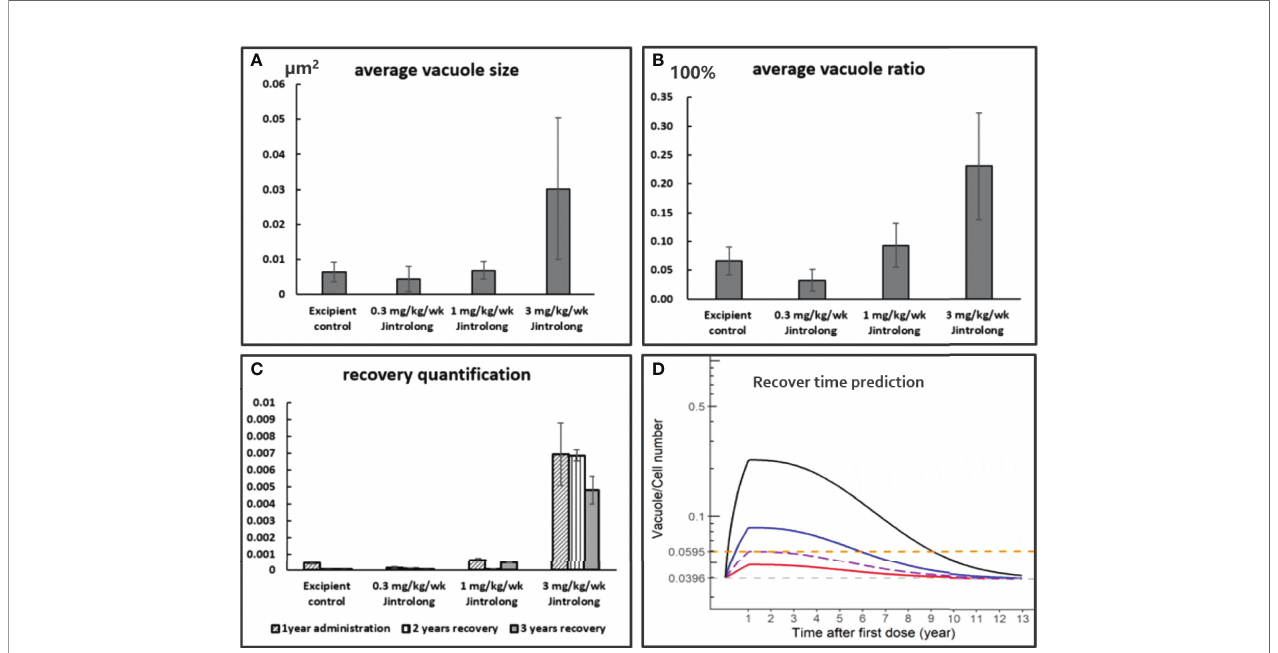
FIGURE 8 | Quanti fi cation and Model based prediction of vacuolation recovery in the CP of cynomolgus monkeys. (A) The average vacuole size is dose-dependent, the y axis is the average vacuole size by µm 2 . (B) The average vacuole ratio is dose-dependent, the y axis is the average vacuole ratio in total CP epithelium. (C) The vacuolation recovery quanti fi cation by average vacuole area multiple average vacuole ratio of cells in CP epithelium. The vacuolation in CP epithelium is completely reversible in middle dose 1 mg/kg/week Jintrolong group and partially reversible in high dose 3 mg/kg/week Jintrolong group. (D) The modeling and simulation data are based on a pharmacokinetic modeling software package NONMEM (the pharmacokinetic modeling method shown in Model Based Prediction of Vacuolation Formation and Recovery in the Cynomolgus Monkeys and in Clinical Pediatric GHD ) and the fi nal graphical data analyzed with R programming. It was predicted to be 8.1 years for vacuolation in high dose 3 mg/kg/week Jintrolong ® group to get completely recovered in cynomolgus monkeys. The predicted minimum dose to induce vacuolation in monkey is 0.55 mg/kg/week. Black line: under dose 3mg/kg/week; blue line: under dose 1mg/kg/week; red line: under dose 0. 3mg/kg/week; Dotted line: predicted threshold dose to induce